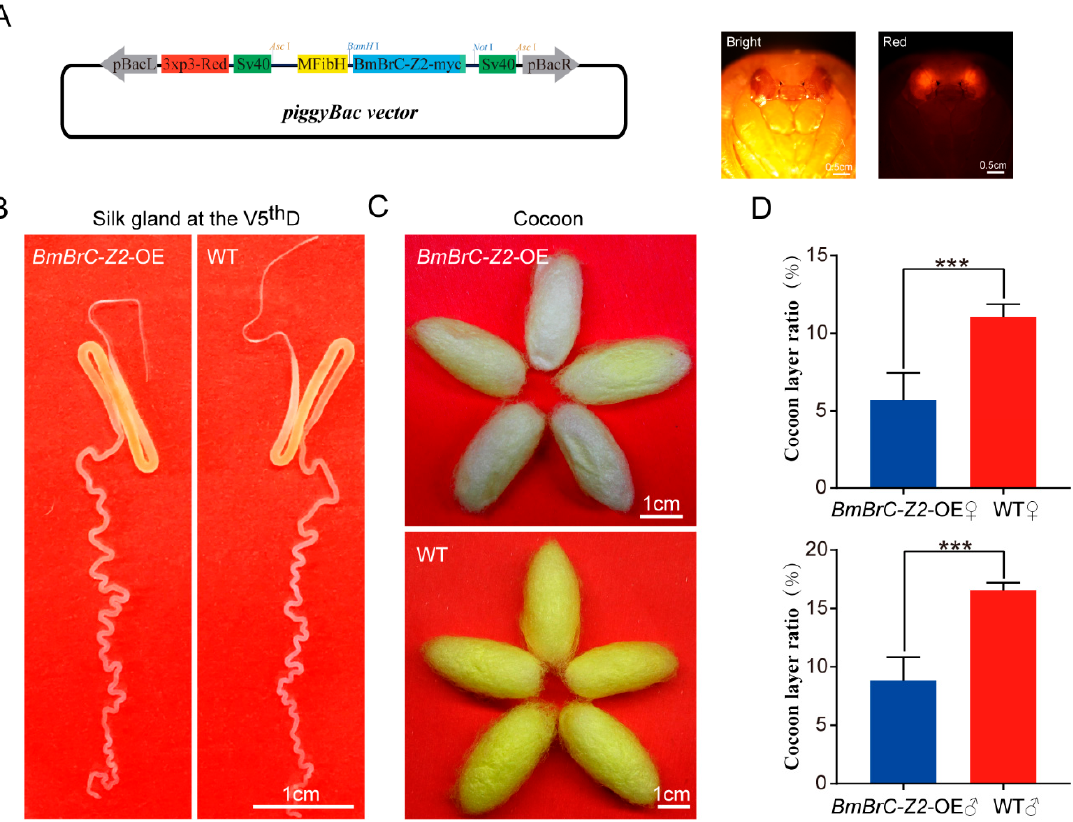
Figure 2. Transgenic overexpression of BmBrC-Z2 in the PSG. ( A ) Transgenic overexpression vector was constructed to overexpress BmBrC-Z2 in B. mori PSG. The positive transgenic phenotype was observed in the pupae; ( B ) silk gland phenotype exhibited no obvious changes at the V5thD; ( C ) cocoons became thinner and lighter and ( D ) cocoon layer ratio (weight of cocoon layer / total weight of cocoon) was obtained by statistical analysis (n = 50). Wild type was used as the control. WT—wild type; OE—overexpression; ***— p < 0.001.